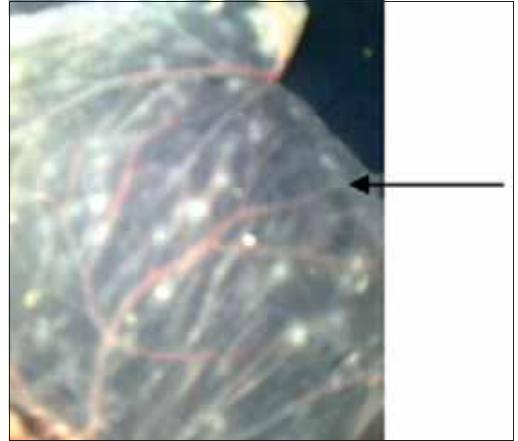
Figure-5: Pocks produced by vaccine strain of fowl pox virus at third passage.